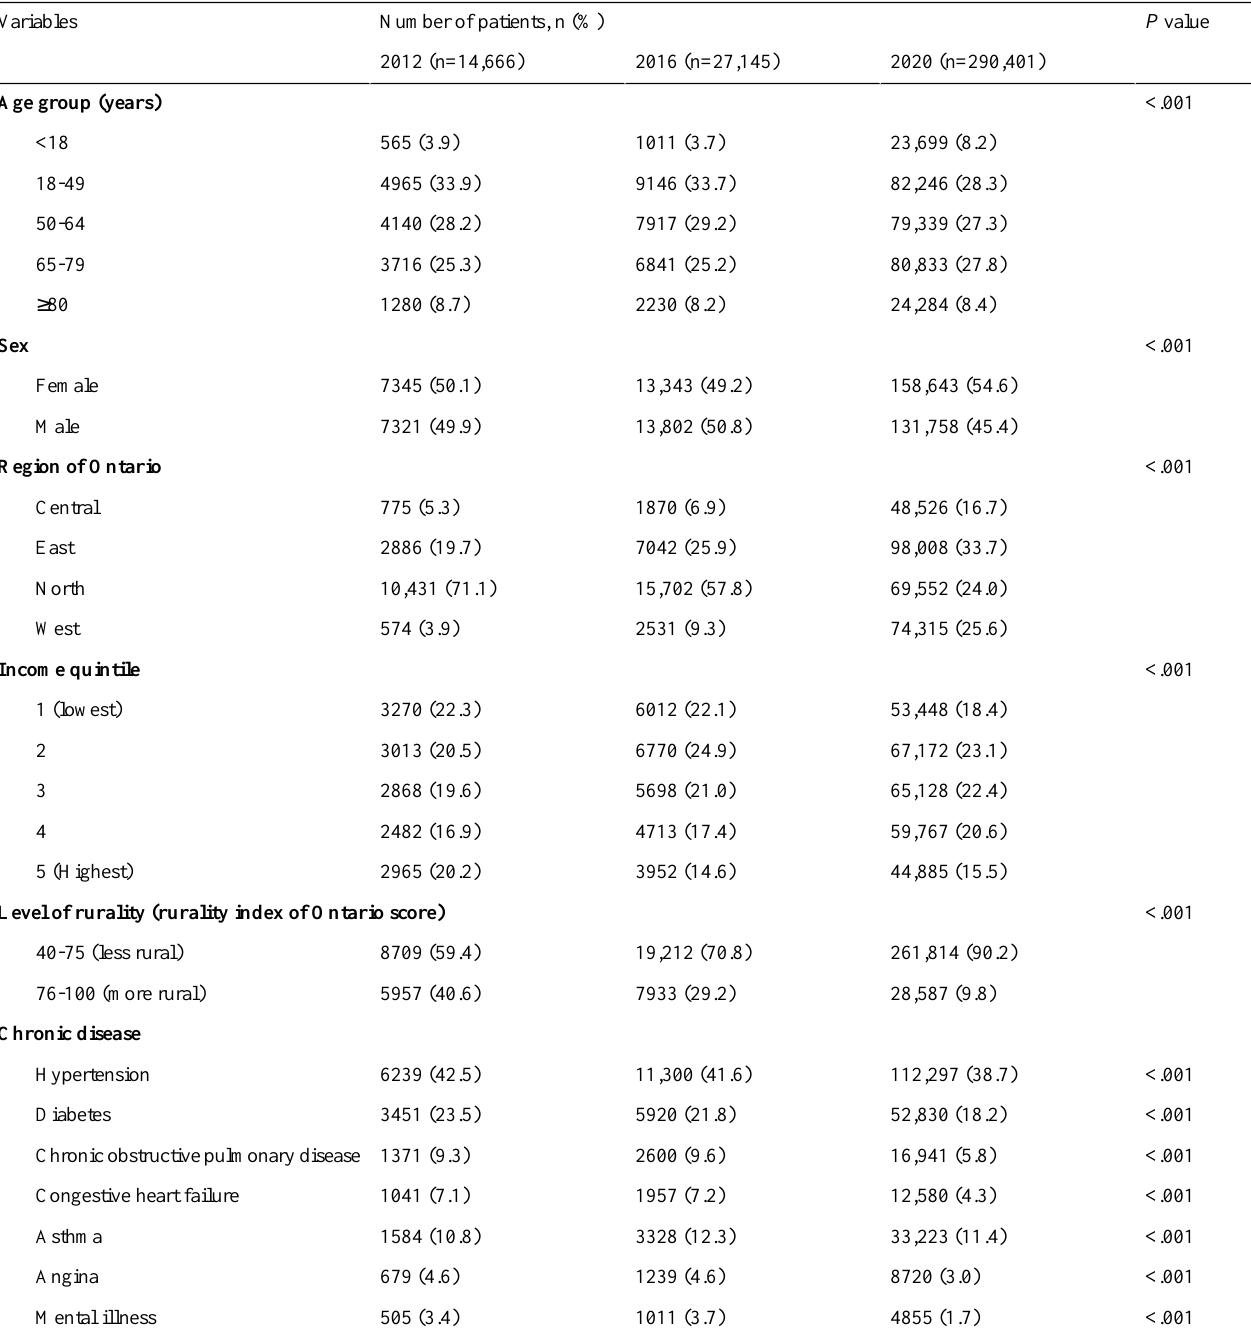
Table 1. Characteristics of rural patients who received at least 1 telemedicine visit in 2012, 2016, and